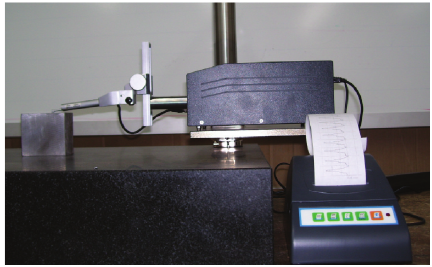
Figure 2: Test rig measuring the surface